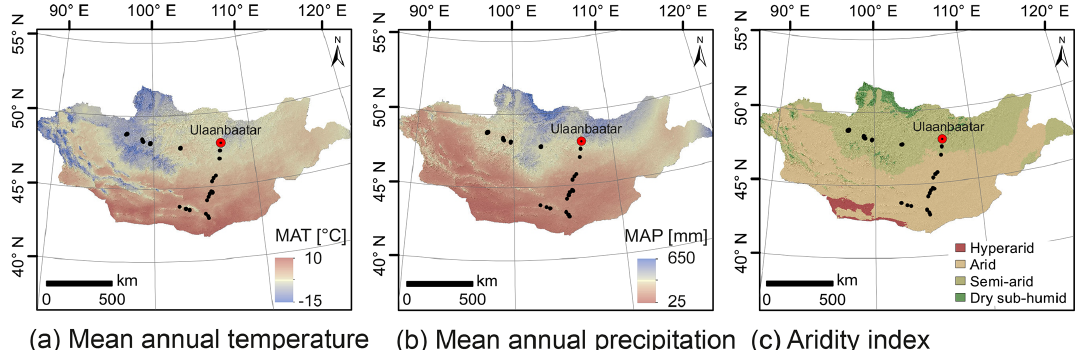
Figure 2. Climate and environmental conditions of Mongolia. Mean annual temperature (a) , mean annual precipitation (b) and the aridity index (c) . MAT and MAP are based on the WorldClim dataset of Fick and Hijmans (2017); the AI is based on the Global Aridity Index and Potential Evapotranspiration Climate Database v2 of Trabucco and Zomer